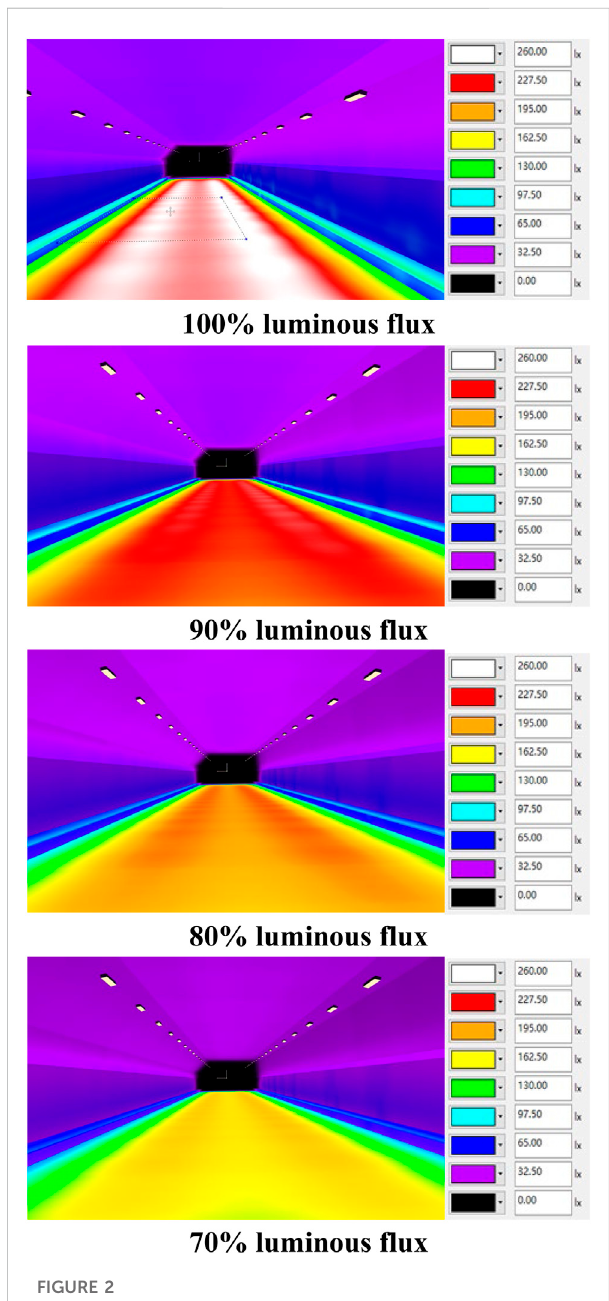
FIGURE 2 Results of luminance simulation of lighting installations in an immersed